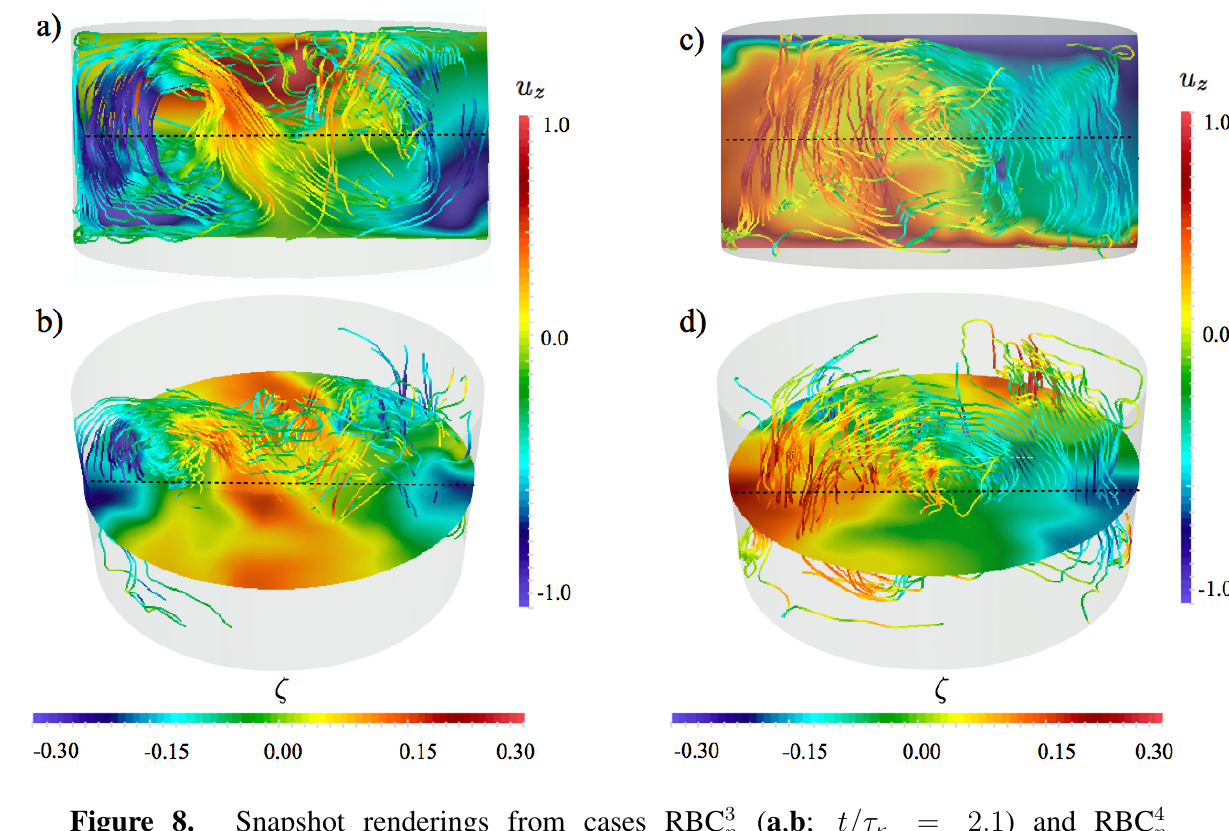
Figure 8. Snapshot renderings from cases RBC 3 = 1 . 7 ). Panels are defined identically to Figure 7. The RBC 3 ( c , d ; t/τ κ at a time when the flow is dominated by a two-roll solution. In contrast, the RBC 4 access this two-roll state, and instead remains in a state with a single large-scale convective roll, a so-called